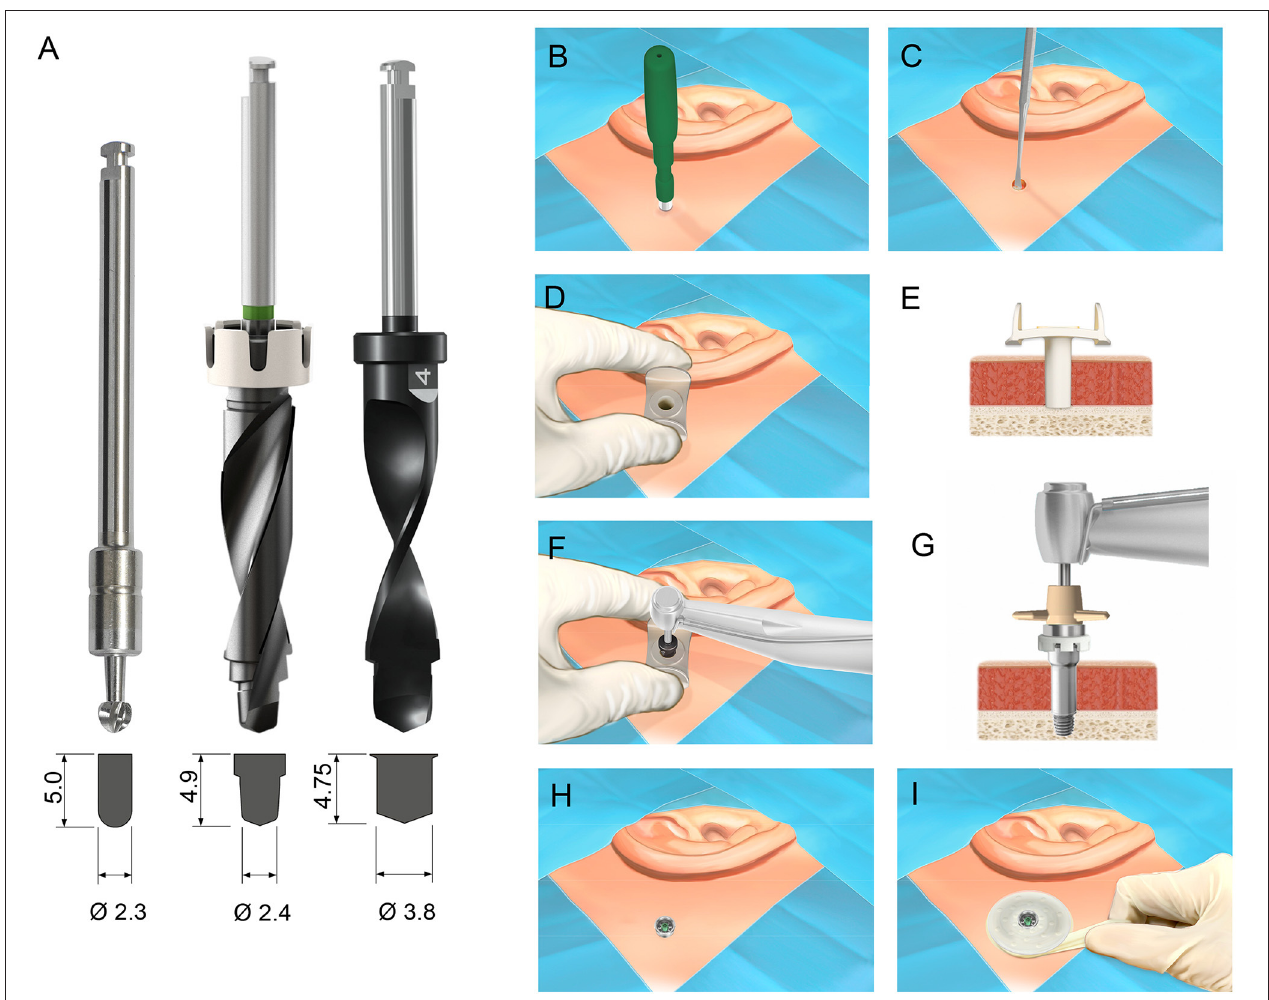
FIGURE 1 | (A) The three drill bits evaluated in the study: the guide drill used the Ponto linear incision technique (left), MIPS guide drill (middle) and MONO drill (right). Below each drill, the shape of the osteotomy site following the drilling sequence using the respective drill is shown. Measurements in millimeters. (B–I) The surgical protocol for implantation of a percutaneous bone conduction device using the MONO procedure. (B) The skin is incised with a 5mm biopsy skin punch. (C) The periosteum is removed from the bone surface at the site. (D,E) The cannula is inserted in the circular incision. (F) Osteotomy is created in one single drill step using the MONO drill. (G,H) The cannula is removed, and the implant is installed. (I) A healing cap and dressing are applied. Images courtesy of Oticon Medical AB ©